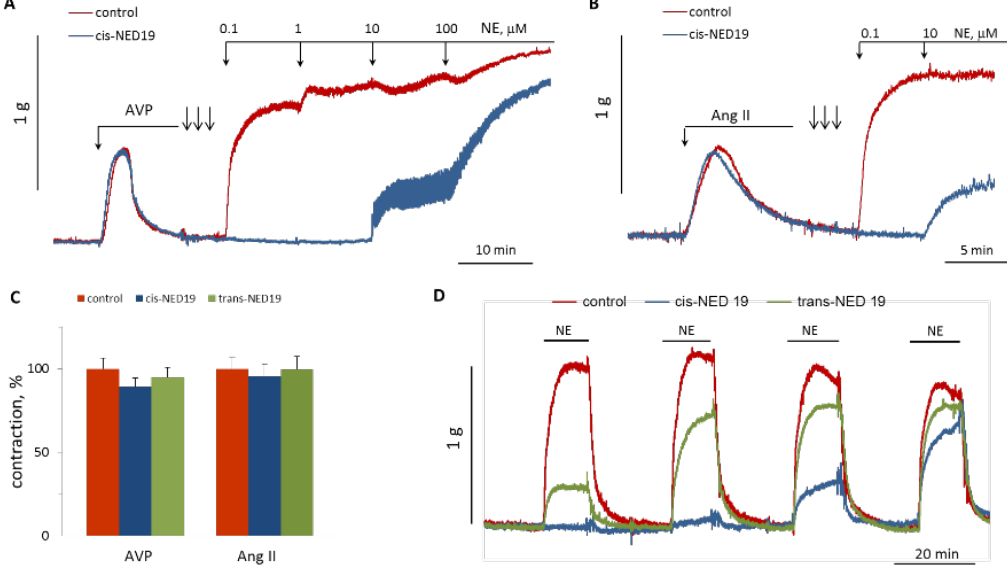
Figure 10. Comparison of NED 19 e ff ects on the force of aortic rings contraction in response to Ang II, AVP and NE. ( A , B ) Lack of 30 µ M cis -NED 19 e ff ect on AVP- or Ang II-induced [Ca 2 + ] i rise and inhibition of NE calcium signaling. The rings were extensively washed from cis -NED 19, Ang II, or AVP (three arrows) before addition of increasing concentrations of NE. ( C ) Contraction of the rings in response to AVP or Ang II in the absence (100%) or presence of 25 µ M cis -NED 19 or trans -NED 19. The values are the mean + SEM from four independent experiments. ( D ) The rings were incubated for 20 min with 10 µ M cis -NED 19, trans -NED 19, or with vehicle before addition of 0.1 µ M NE. Then, the rings were extensively washed and NE was added again. The procedure of washing and adding NE was repeated two more times. The typical results of one of three experiments are shown on each graph (A,B,D).